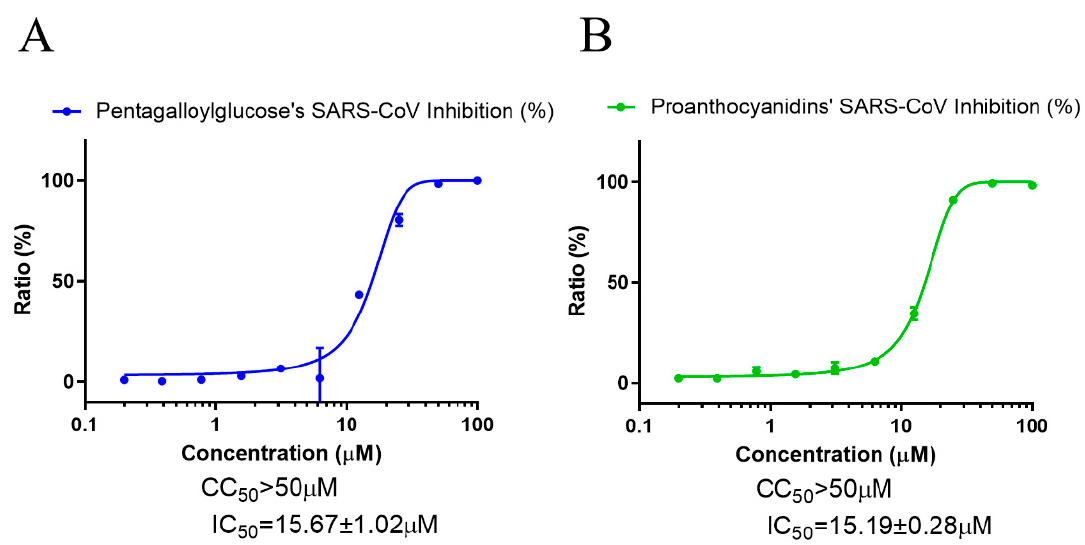
Figure 5. Anti-SARS-CoV activity of PGG and PAC. ( A ) The dose–response curve analysis using the immunofluorescence-based antiviral assays presented the antiviral effect of PGG ( A ) and PAC ( B ) on the SARS-CoV infection in Vero cells. Blue circles ( A ) and green circles ( B ) indicate the inhibition percentage of the SARS-CoV infection by PGG and PAC, respectively, in a dose-dependent manner. The data represent duplicate experiments, and are presented as the mean ± SEM.